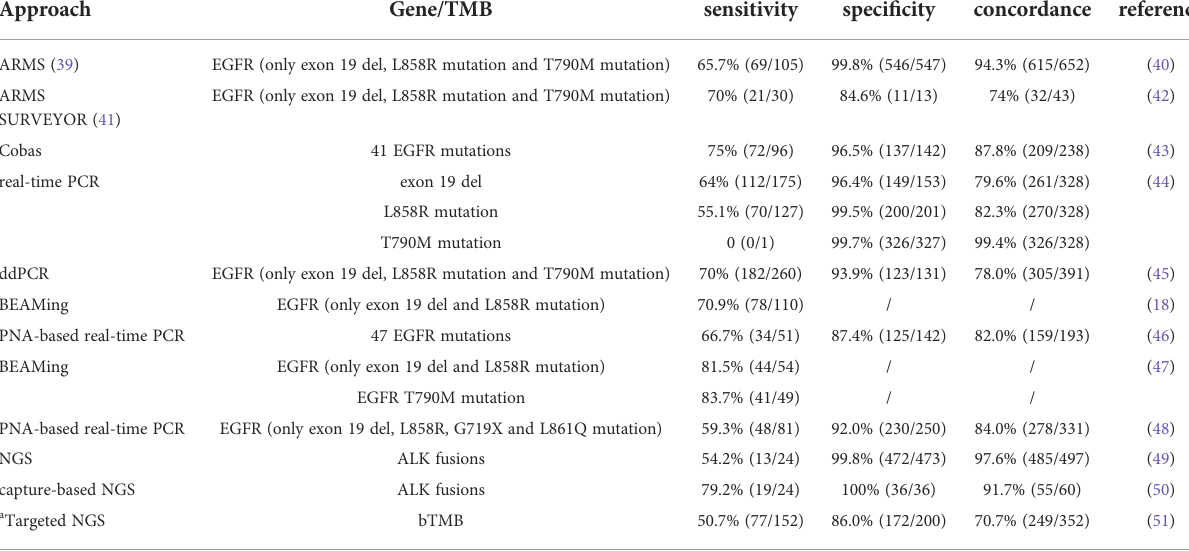
TABLE 1 The mutation results obtained and compared between tumor and plasma DNA